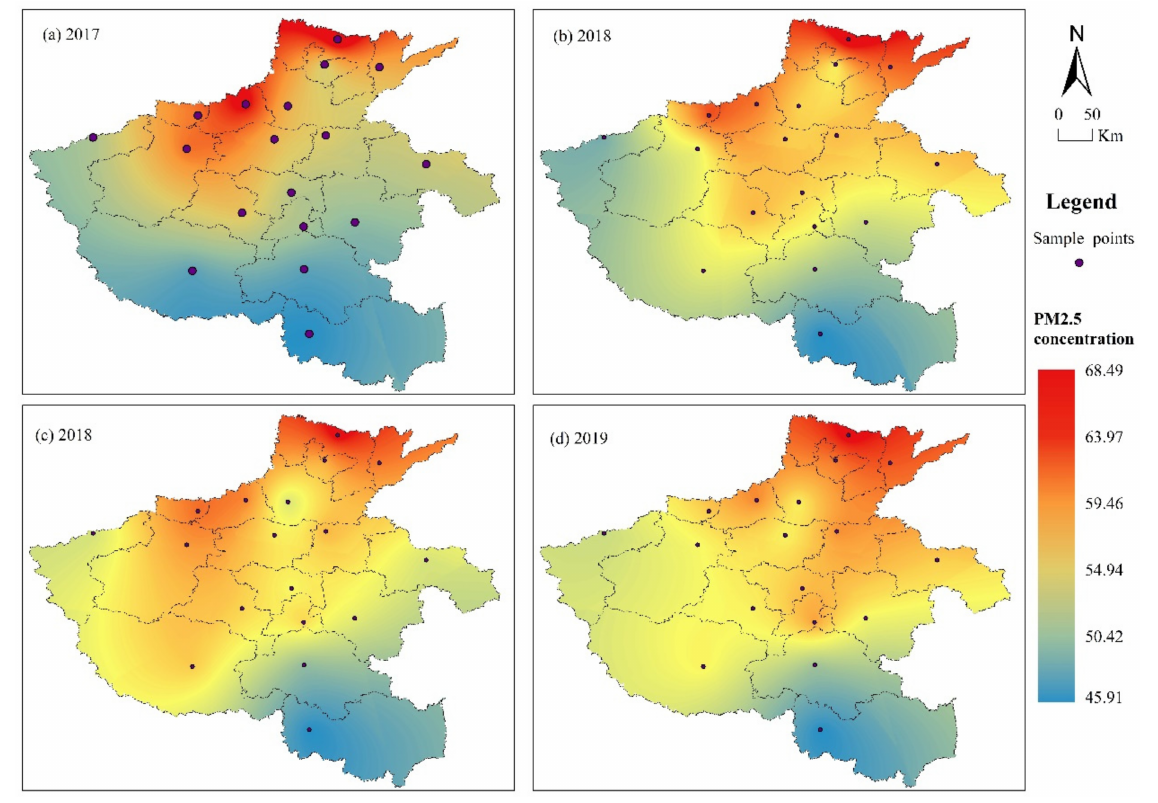
Figure 3. Spatial patterns of PM 2.5 concentrations and their changes in Henan